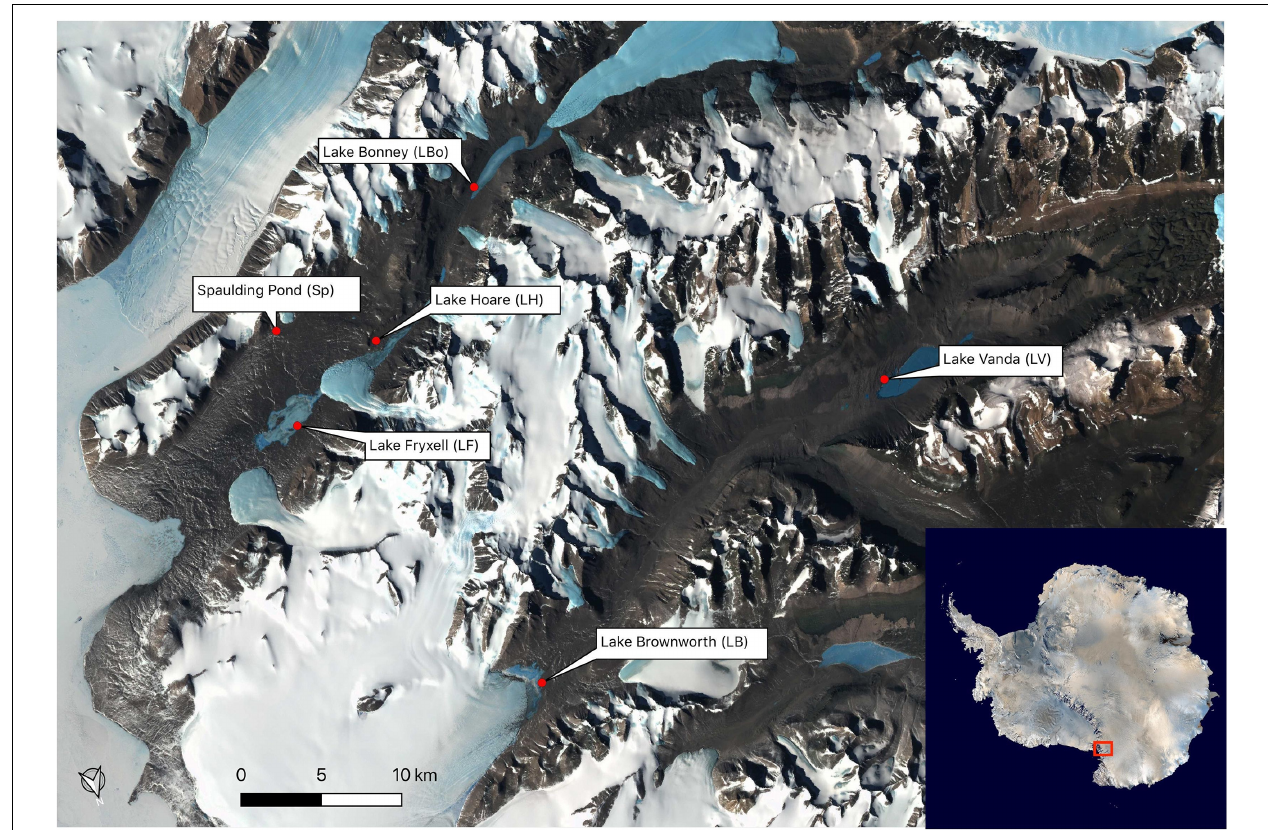
FIGURE 1 | Sampling locations in Wright Valley and Taylor